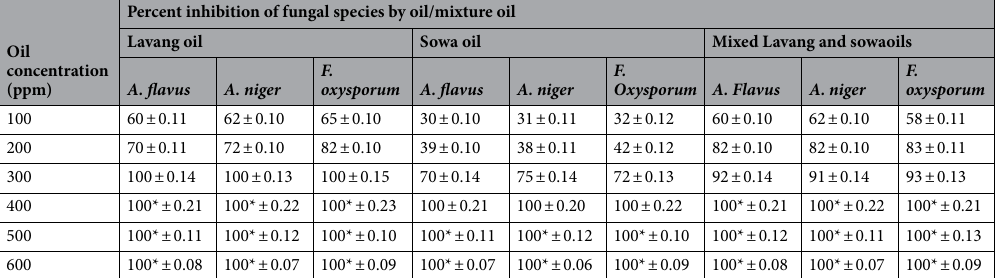
Table 3. Minimum inhibition concentration (MIC) of Lavang, sowa leaf oil and mixture oil. SD standard deviation. *Fungicidal; *Values given are mean of three replicates.